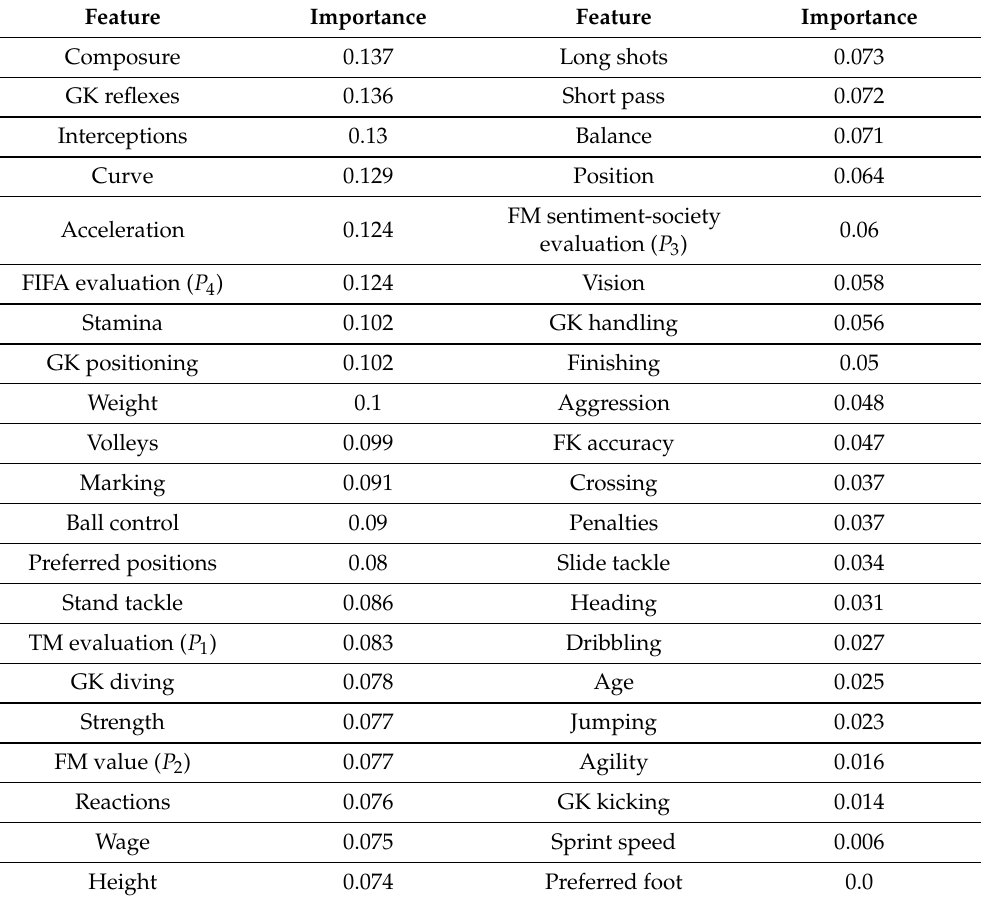
Table 1. Results of the feature importance analysis obtained through the proposed